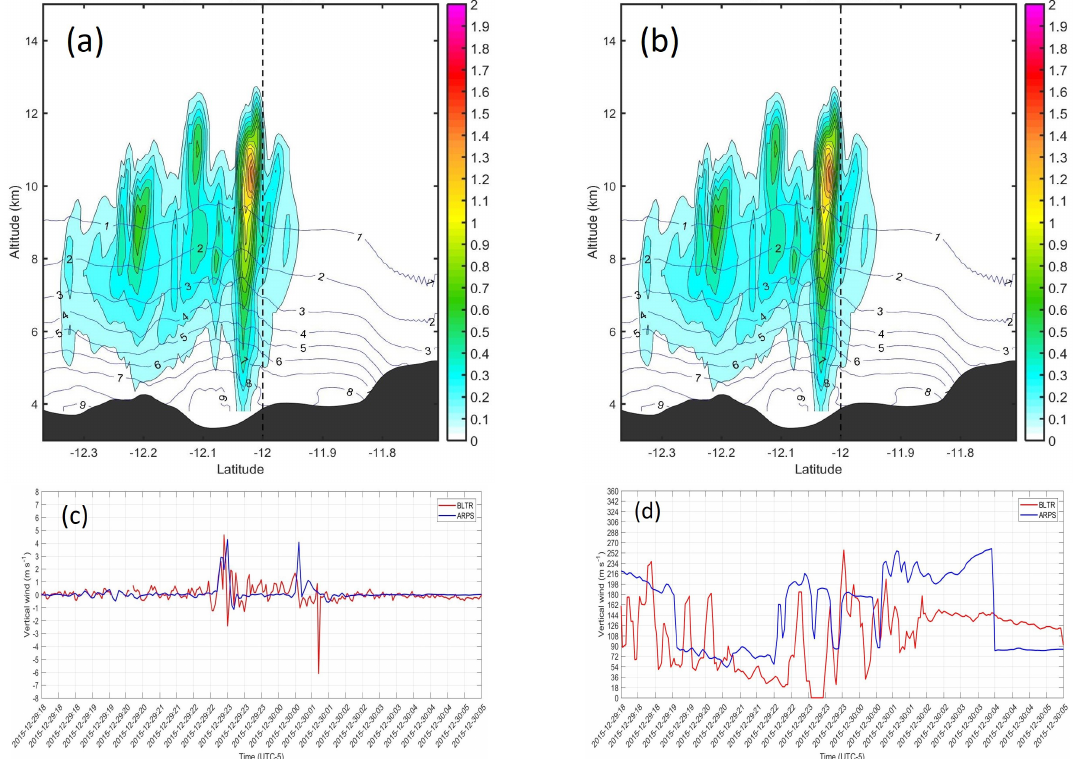
Figure 13. Vertical cross section of hail mixing ratio (g kg − 1 ) along ( a ) longitude and ( b ) latitude of the Huancayo observatory showed with vertical dotted lines. All fields were obtained from the ARPS model (resolution: 0.5 km) at 0115 UTC (2015 LT) of 30 December, 2015 (TS1); ( c ) Time series of vertical wind speed (m s − 1 ) obtained with the BLTR radar (red line) and the ARPS model (blue line) at 3000 m high from the surface for the TS1 event; ( d ) Time series of wind direction at 6000 m high from the surface during the TS1 event obtained with the BLTR radar (red line) and the ARPS model (blue line)